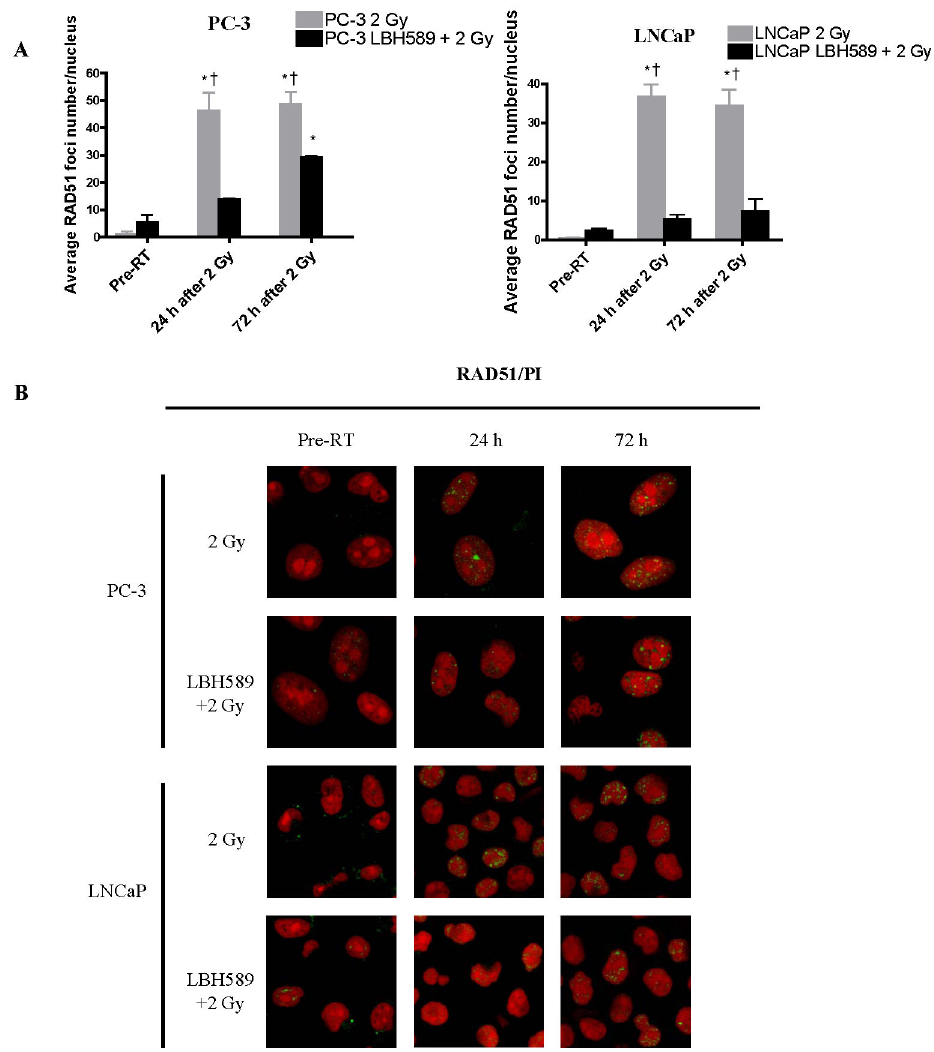
Figure 7. Quantitative analysis of DSB repair marker in the HR pathway for RAD51 foci at pre-RT, 24 h and 72 h after 2 Gy RT or combination treatment in PC-3 and LNCaP cells. ( A ) After 2 Gy RT, average RAD51 foci number increased significantly at 24 and 72 h in both PC-3 and LNCaP cells, while average BRCA1 foci number in combination-treated (LBH589+2 Gy RT) cells was also increased at 24 and 72 h, but was significantly lower than that in RT-treated cells. ( B ) Representative images of RAD51 staining after 2 Gy RT or combination treatment (LBH589+2 Gy RT) in PC-3 and LNCaP cells. p <0.05(†) indicates significant difference between RT-treated cells and combination-treated cells at the same time point. p <0.05(*) indicates significant difference between cells at specific time points and cells receiving the same treatment at the “Pre-RT” time point. Points, mean; bars, SD. N=50. Typical images are shown from three independent experiments (N=3). Magnification × 60 in all images. doi: